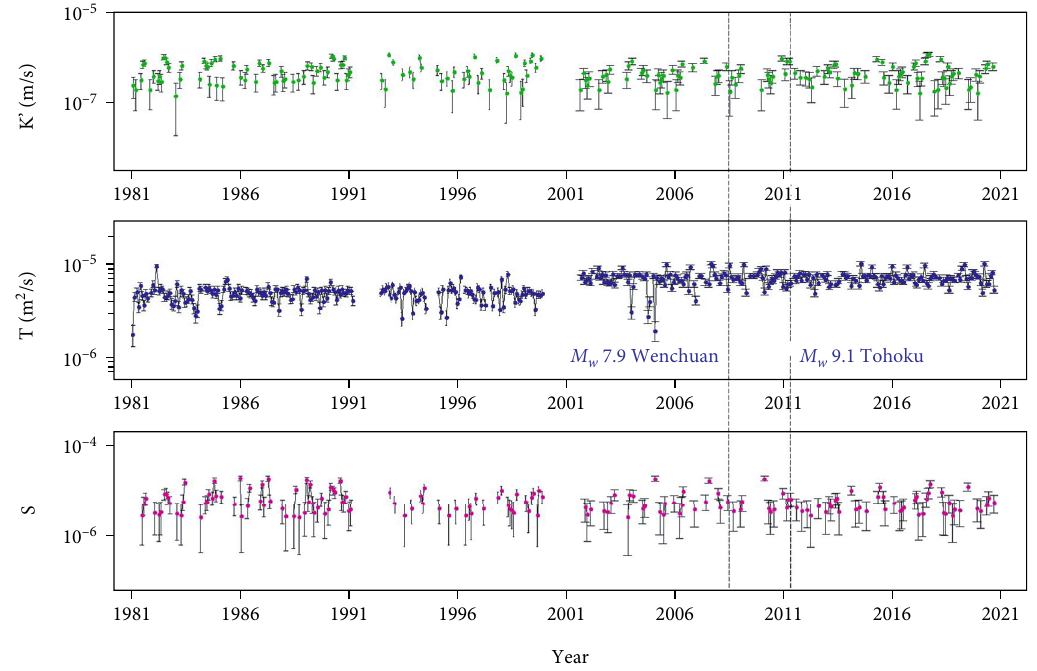
Figure 6: Inverted vertical hydraulic conductivity K ′ of the aquitard and the horizontal transmissivity T and storativity S of the aquifer from the leaky model of Wang et al. [9] for well Gaocun. The vertical dashed lines represent the start time of the 2008 Wenchuan and the 2011 Tohoku huge earthquakes, which caused no impact on those parameters. Some kick points induced by the unstable fi tting perhaps incurred by the simpli fi cations of the model assumptions (see Section 5.2) are neglected and not shown in the fi gure, which could disturb and obscure the dots in the fi gure. ∗ We calculated the errors based on the data from January 1981 to December 1990 (which is relatively stable and continuous) and obtained the error of the hydraulic conductivity K ′ with 1 : 20 × 10 − 7 (m/s), that of the horizontal transmissivity T with 7 : 75 × 10 − 7 (m 2 /s) and the horizontal storativity S with 9 : 31 × 10 − 6 .